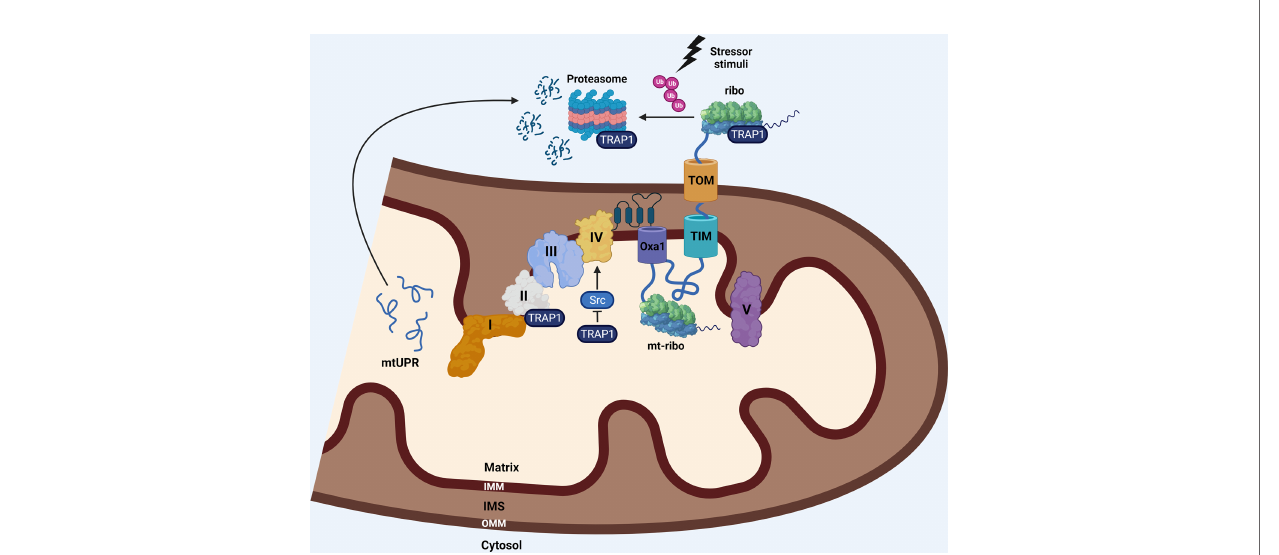
FIGURE 2 | The nuclear-encoded mitochondrial proteins are synthesized by cytosolic ribosomes (ribo) that can be localized at the OMM, allowing co-translational import of nascent proteins into the organelle via the TOM/TIM complexes. Translating ribosomes can act as a platform for early PQC by ribosome-associated chaperones, including TRAP1, that, under stress conditions, prevents aberrant aggregation of proteins, directing them to co-translational ubiquitin-mediated proteasomal degradation. The imported proteins taking part to respiratory complexes are then assembled in supercomplexes along with the 13 components that are synthesized within the organelle by the mitochondrial ribosomes (mt-ribo). The co-translational insertion of these subunits into the IMM is mediated by OXA1, which is crucial for the assembly of functional respiratory complexes. The same molecular chaperone assisting PQC of mitochondrial proteins, TRAP1, is contemporary a regulator of respiration, through a direct binding to complex II, and an indirect regulation on complex IV, through the stabilization of the inactive form of c-Src, which is known to stimulate complex IV activity. Inhibition of TRAP1 leads to a mtUPR and related stress response. I, II, III, IV: respiratory complexes